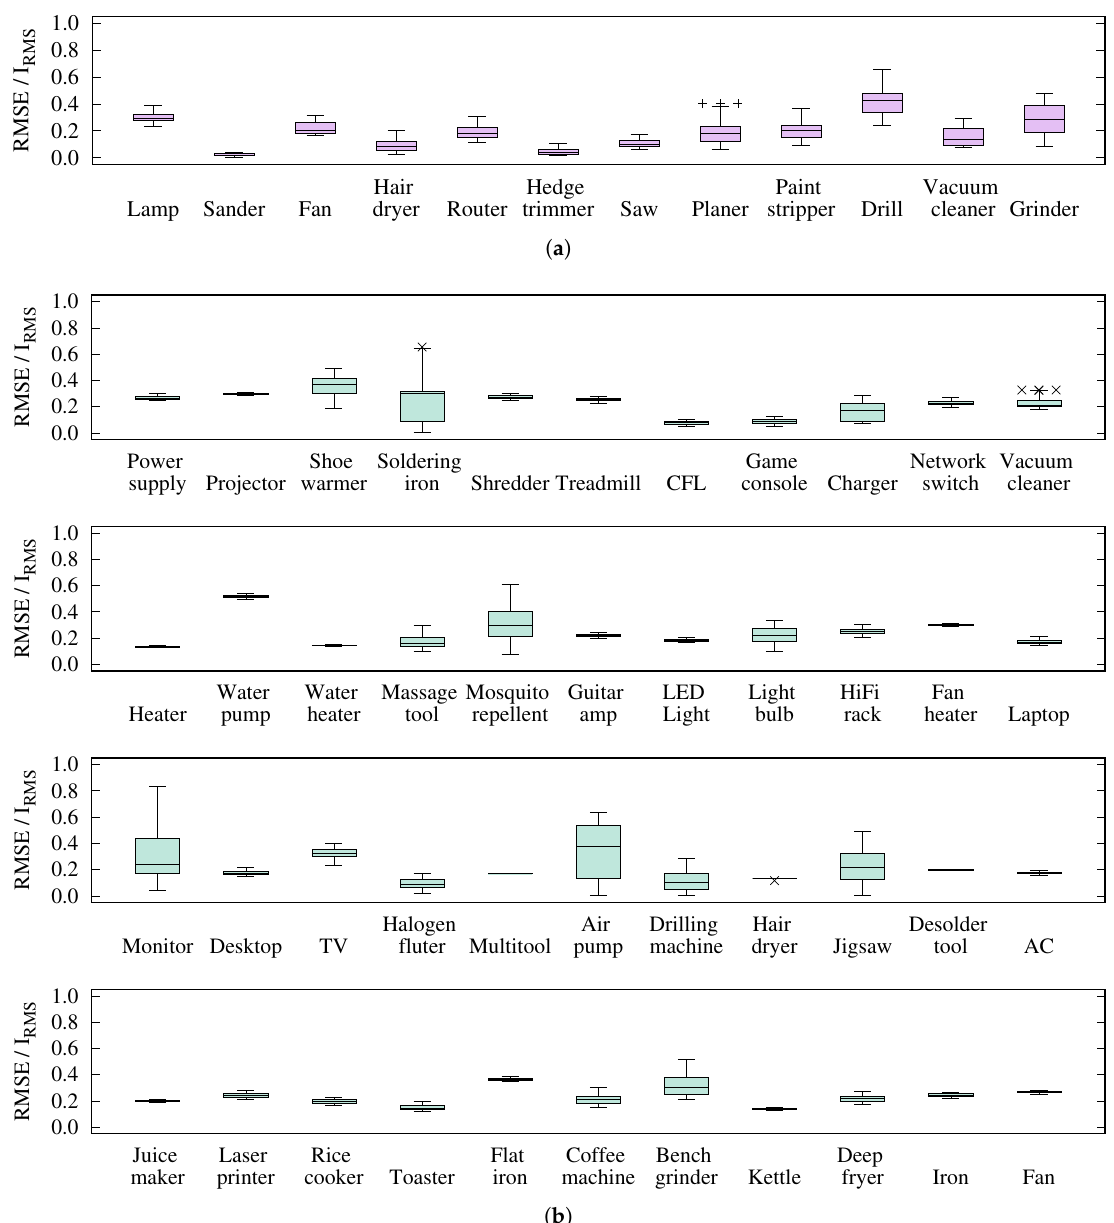
Figure 11. Reconstruction RMSE relative to each appliance’s nominal input current I RMS for each appliance type. ( a ) COOLL data set (using 7 templates); ( b ) WHITED data set (using 23